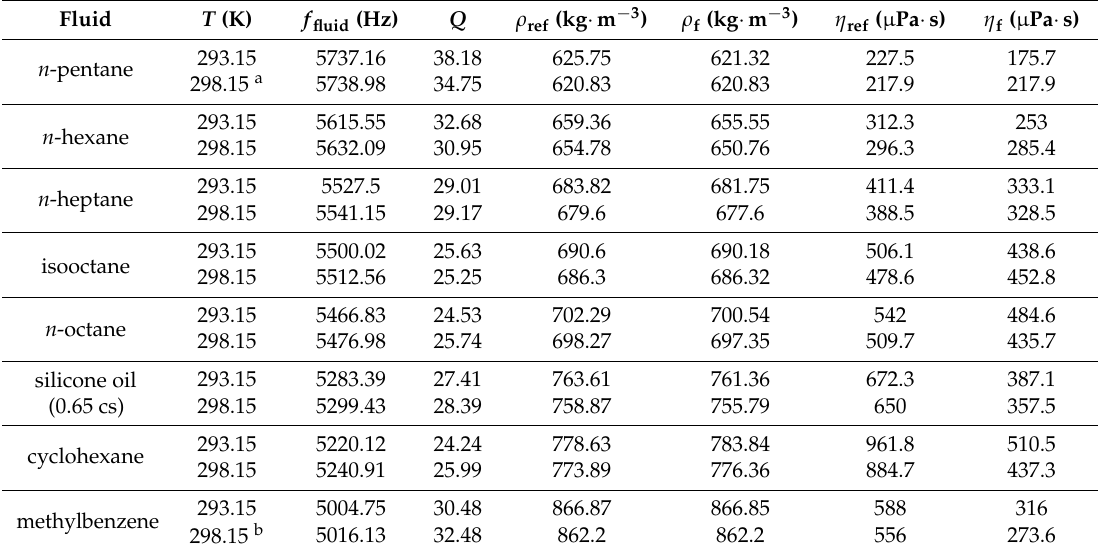
Table 1. Experimental results of rectangular micro-cantilever chip under flexural resonant mode.